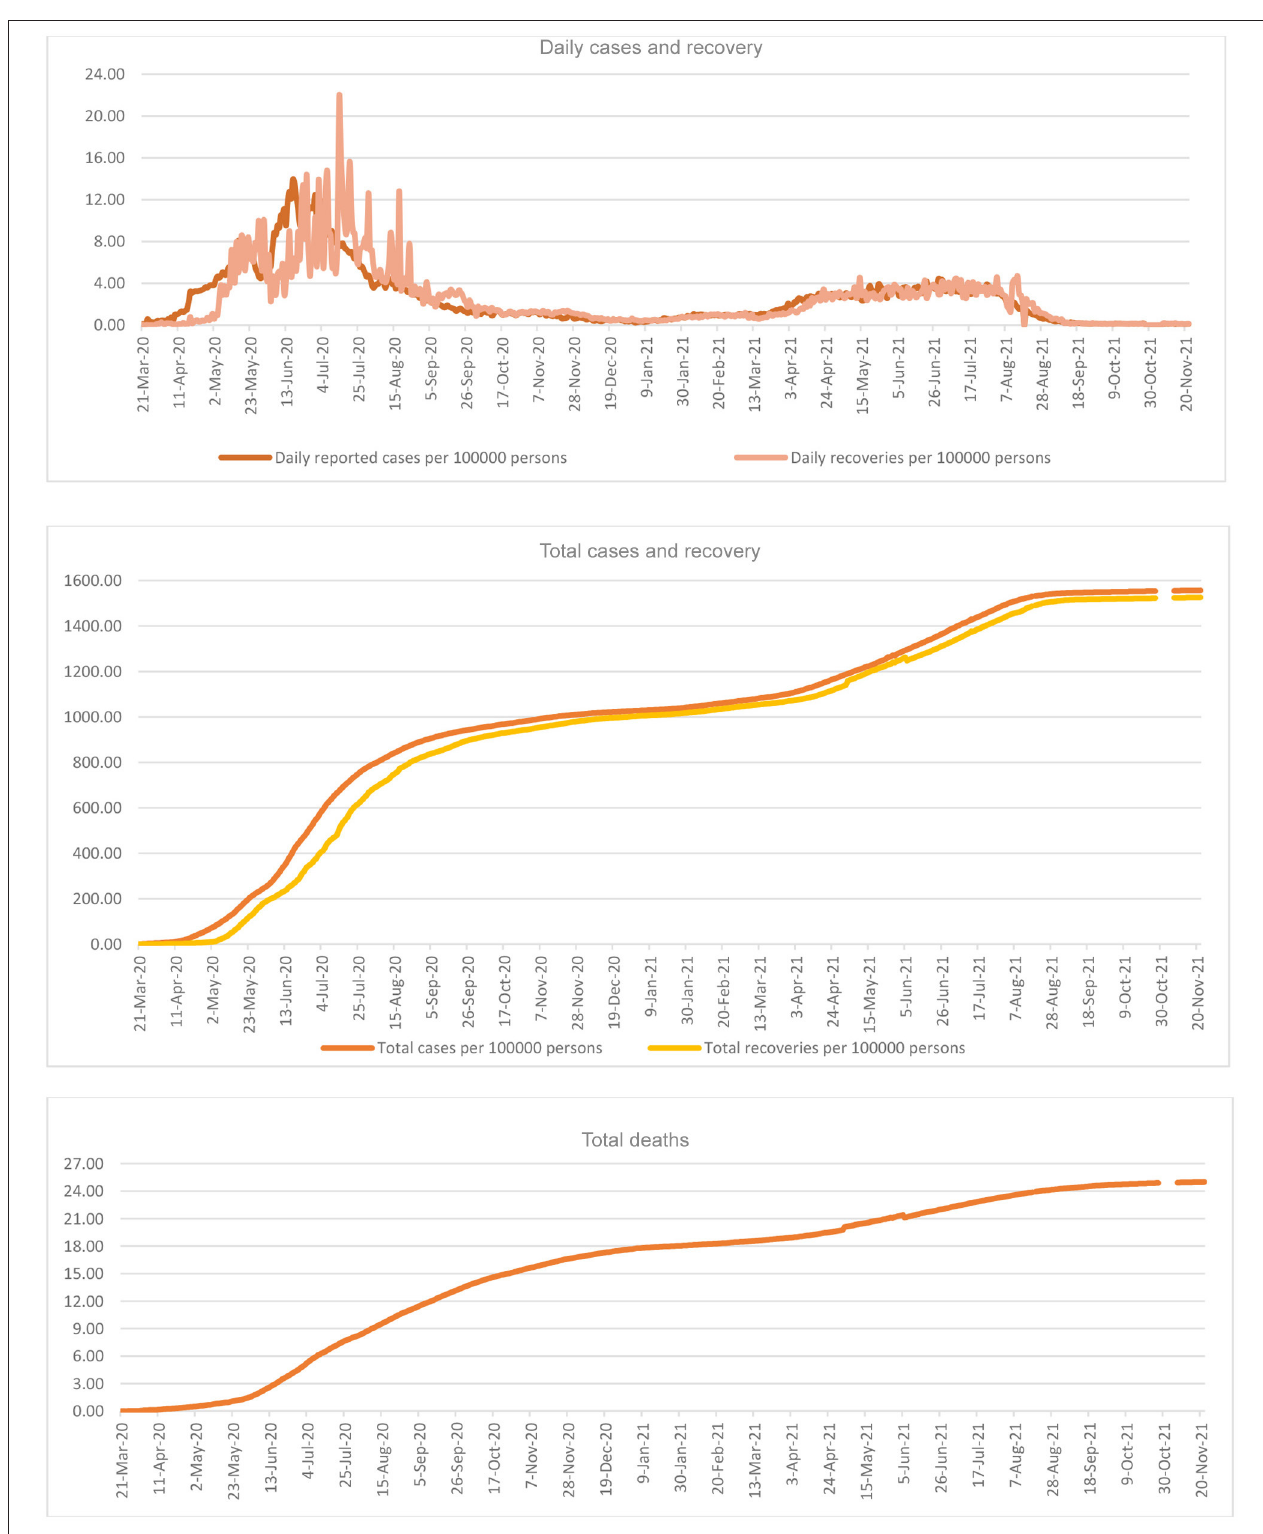
FIGURE 3 | COVID-19 Infections in per 100,000 persons in Saudi Arabia.